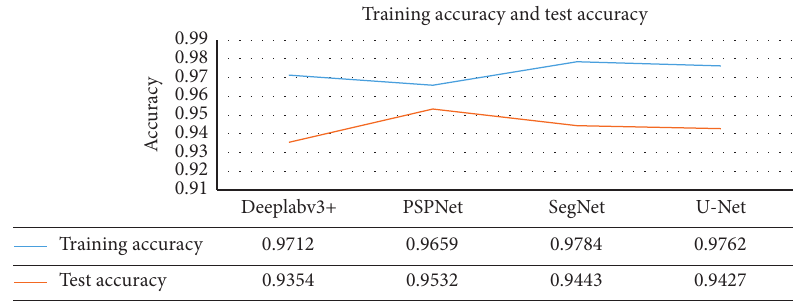
Figure 7: Training accuracy and test accuracy of the four networks.